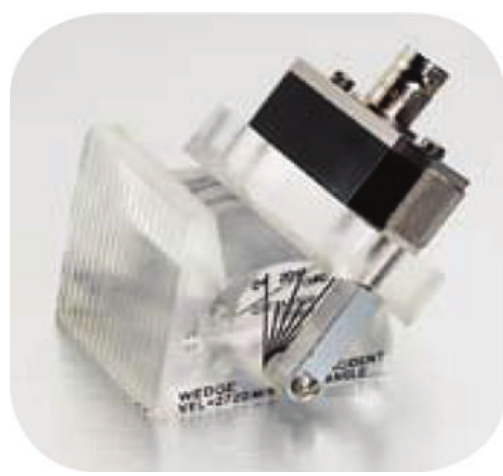
Figure 4: Olympus NDT variable angle beam